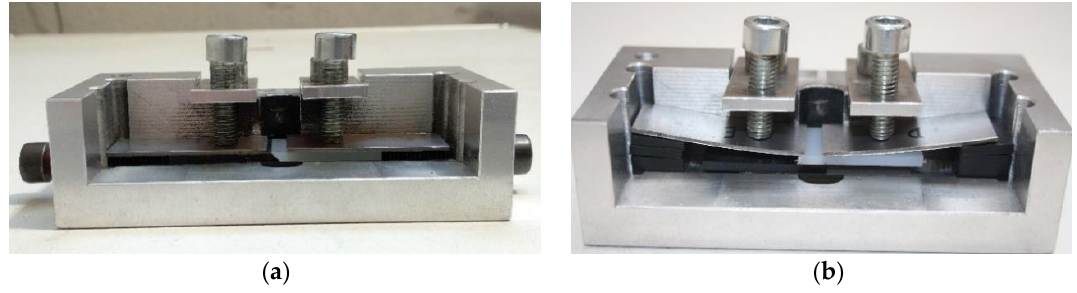
Figure 3. Clamp system: ( a ) butt joint sample; ( b ) lap joint sample.